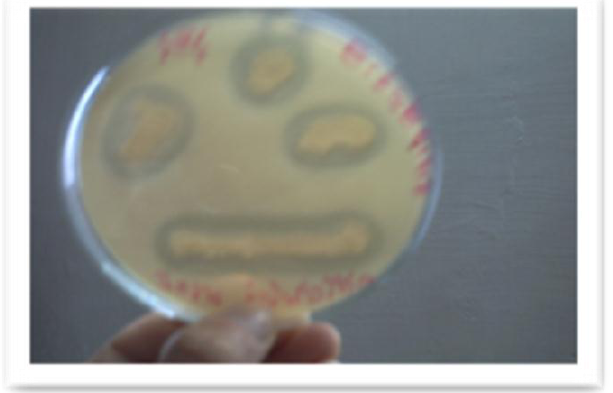
Fig(2) Inhibition zone of Bacillus subtilis against Aeromonas hydrophila after incubated Bacillus 2